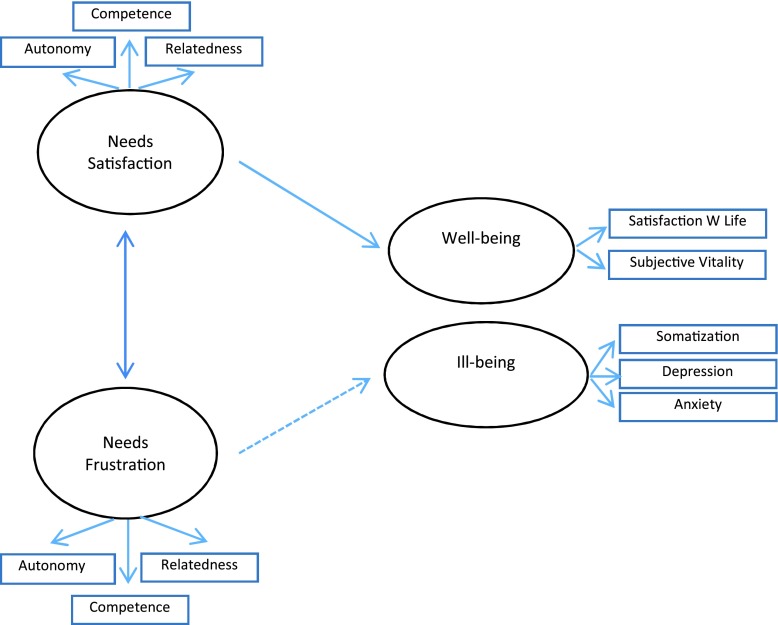
Model Overview. SEM Model 1 and 2. Note: Solid line: Model 1; Dotted line: Model 2.